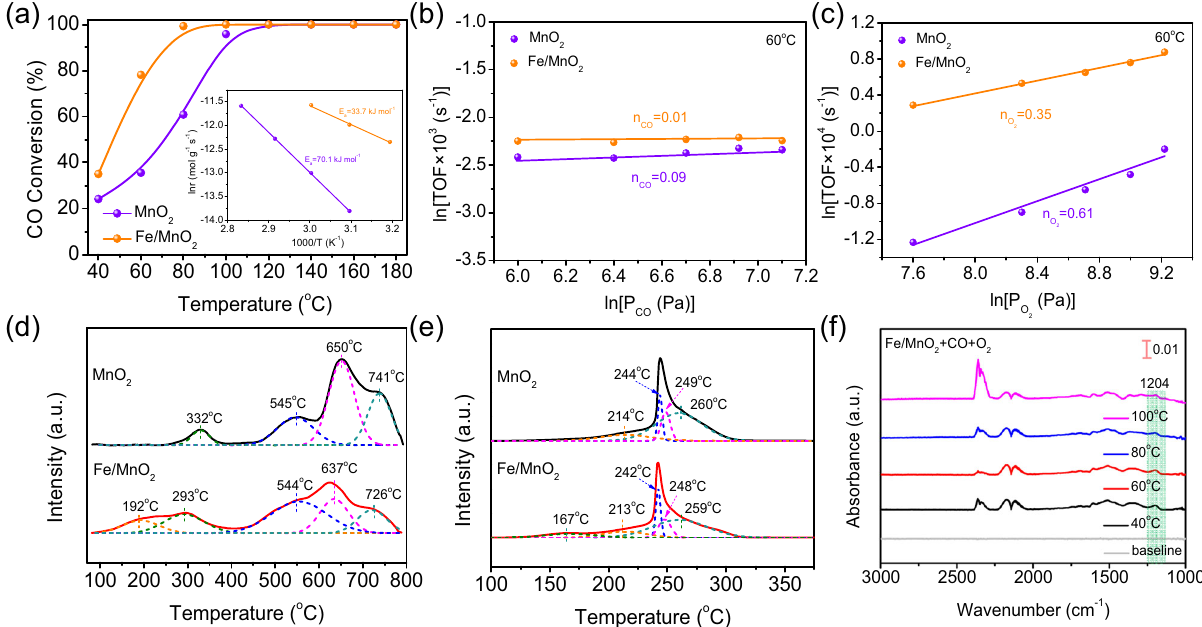
Fig. 2 Detection of active species. a Light-off curves of CO oxidation over Fe/MnO 2 and MnO 2 (the inset shows associated Arrhenius plots). Effect of ( b ) CO and ( c ) O 2 partial pressure on TOF of supported Fe/MnO 2 and MnO 2 at 60 °C, respectively. d O 2 -TPD pro fi les and e H 2 -TPR pro fi les of Fe/MnO 2 and MnO 2 . f In-situ DRIFTS of CO oxidation over Fe/MnO 2 in a continuous fl ow of 1% CO/4% O 2 /N 2 at different temperatures. (Fig. 2d). The O 2 -TPD pro fi le of MnO 2 could be deconvoluted an additional characteristic peak at 192 °C appeared in the into four peaks of <400, 400 – 550, 550 – 700 °C and above 700 °C, spectrum of Fe/MnO 2 , suggesting the emergence of new oxygen species formed on the surface. The formation of new oxygen corresponding to surface adsorbed oxygen (O ad ), surface lattice species in Fe/MnO 2 was further con fi rmed by the new char- oxygen (S-O latt ) bound to Mn 3 + , S-O latt and bulk lattice oxygen (B-O latt ) bound to Mn 4 + , respectively 22 . Besides these four peaks, acteristic peak located at 167 °C in H 2 -TPR (Fig. 2e) and the NATURE COMMUNICATIONS| (2021) 12:5422